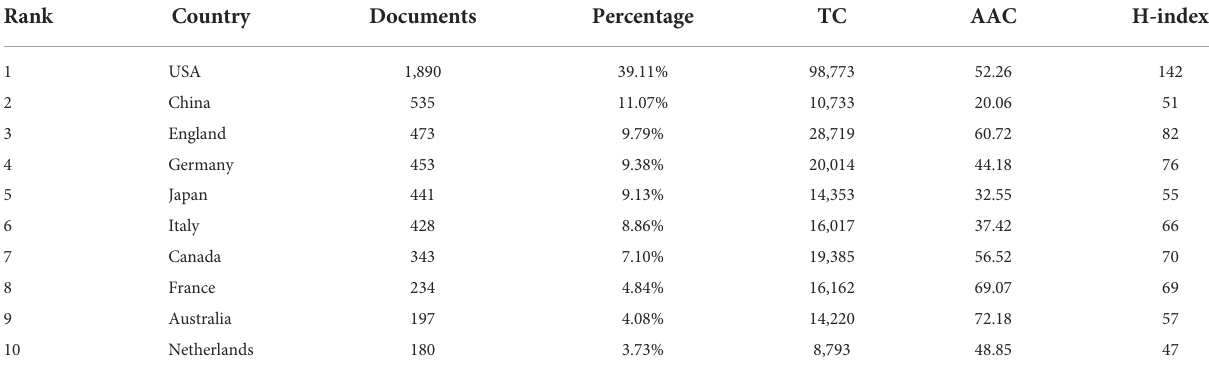
TABLE 1 Top 10 productive countries/regions associated with the bone metastases in prostate cancer. Rank